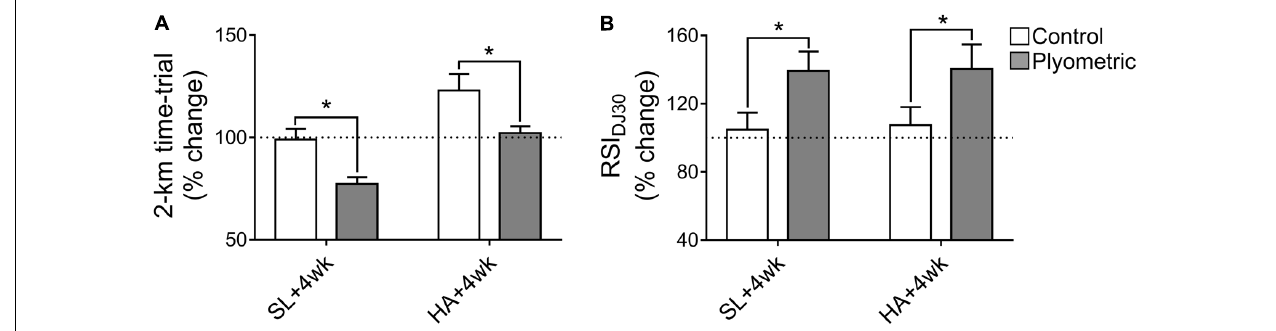
FIGURE 2 | Effect of 4 weeks plyometric training on a 2-km time-trial running test and 30 cm drop jump reactive strength index (RSI DJ30 ). SL +4 week: sea level performance after 4 weeks of plyometric training; HA+4 week: performance after 24 h of high-altitude exposure (3,270-m over sea level) after 4 weeks of plyometric training. (A) Note that at SL +4 week the plyometric training group displayed an improvement in 2-km time-trial compared to the control group. At HA +4 week, the control group displayed a reduction in 2-km time-trial performance compared to sea level, and the plyometric training group showed a better performance compared to the control group. (B) At SL +4 week and at HA +4 week the plyometric training group displayed an improvement in RSI compared to the control group. ANOVA with 2 factors, followed by Holm-Sidak post hoc ; ∗ p < 0.05. Dotted line reflects baseline performance at sea-level.